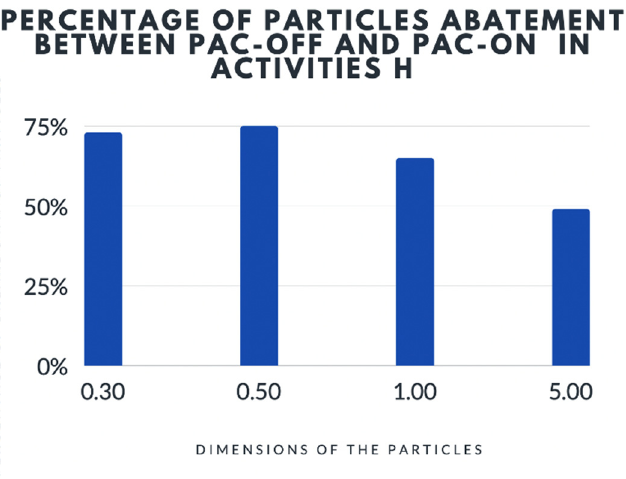
Figure 6. Analysis of particles during activity H with PAC off and on. PAC = Portable Air Cleaners.